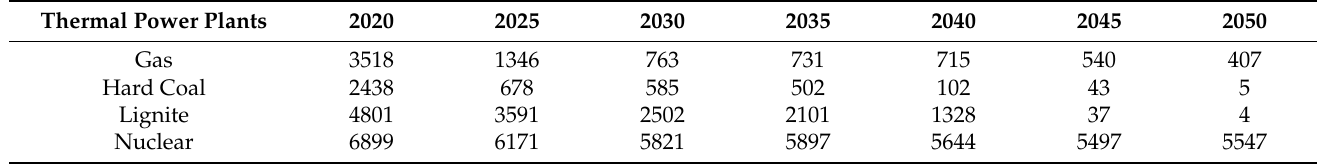
Table 1. FLH of thermal power plants per year in solidEU.